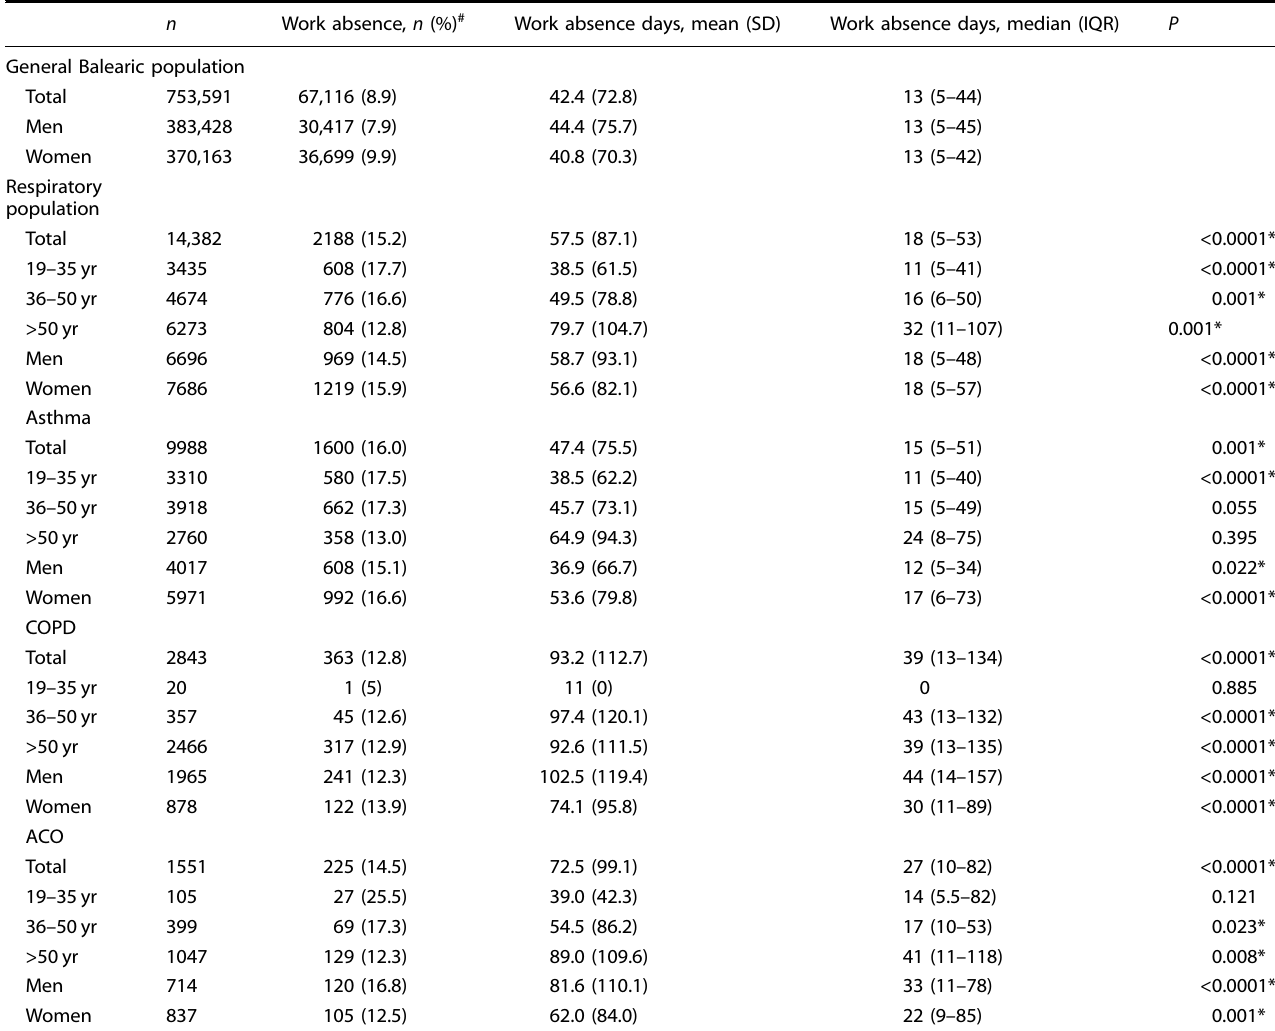
Table 2. Work absence in the Balearic asthma and/or COPD population and the Balearic general population aged 19 – 65 years in 2012. n Work absence, n (%) # Work absence days, mean (SD) Work absence days, median